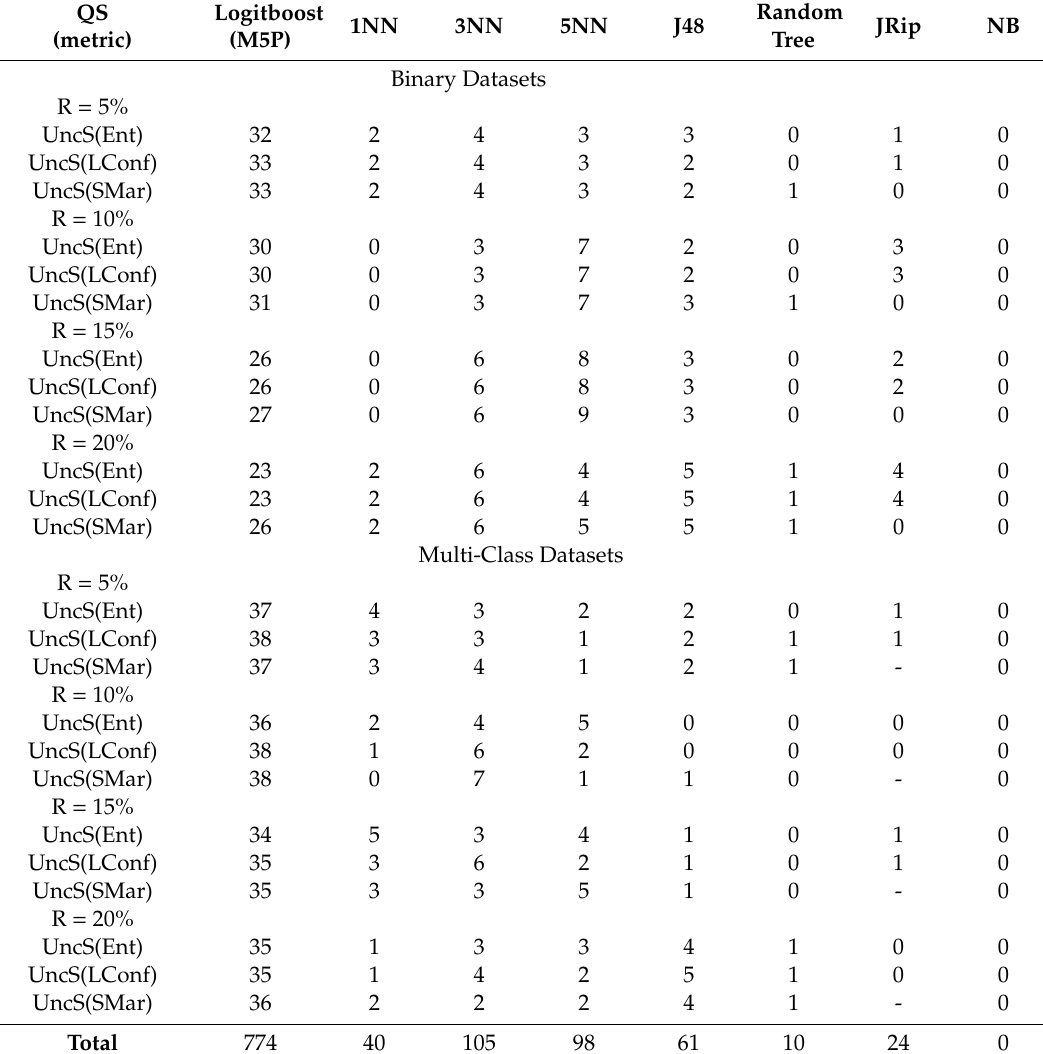
Table 7. Number of best achieved performances over the examined datasets per base learner for the included query strategies and R-based experiments the comparison of simple learners.